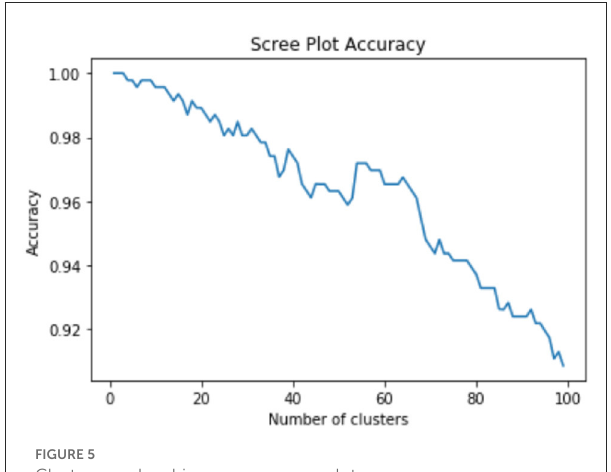
FIGURE5 Cluster membership accuracy scree plot.